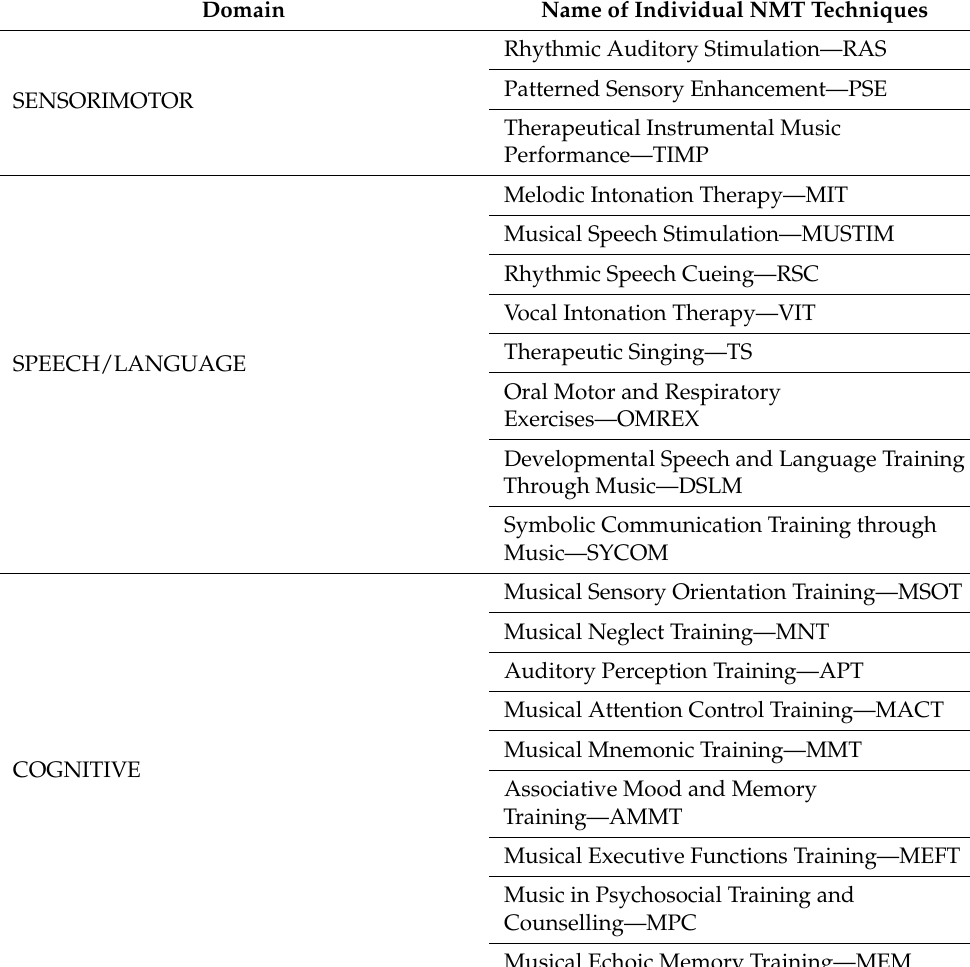
Table 1. The division of neurologic music therapy techniques into three main groups that rehabilitate certain areas and the specific techniques used in